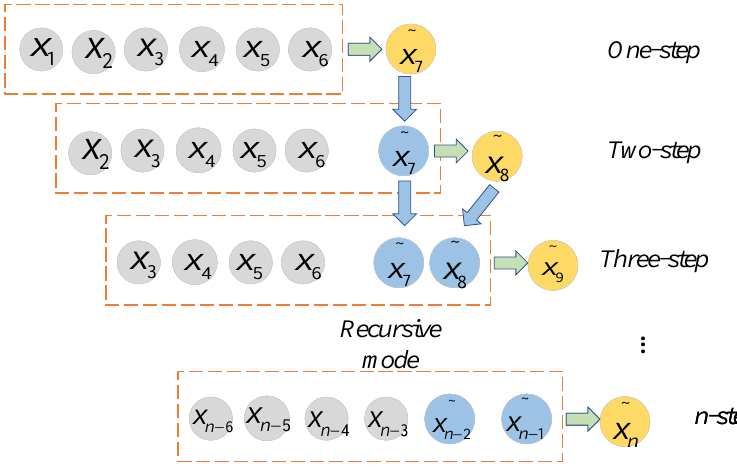
Figure 1. Sliding window approach for multi-step.